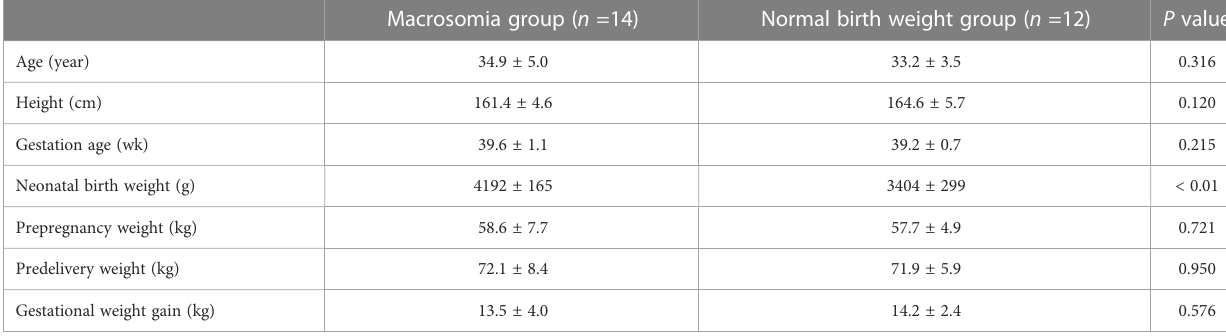
TABLE 5 Clinical information for pregnant women who provided human